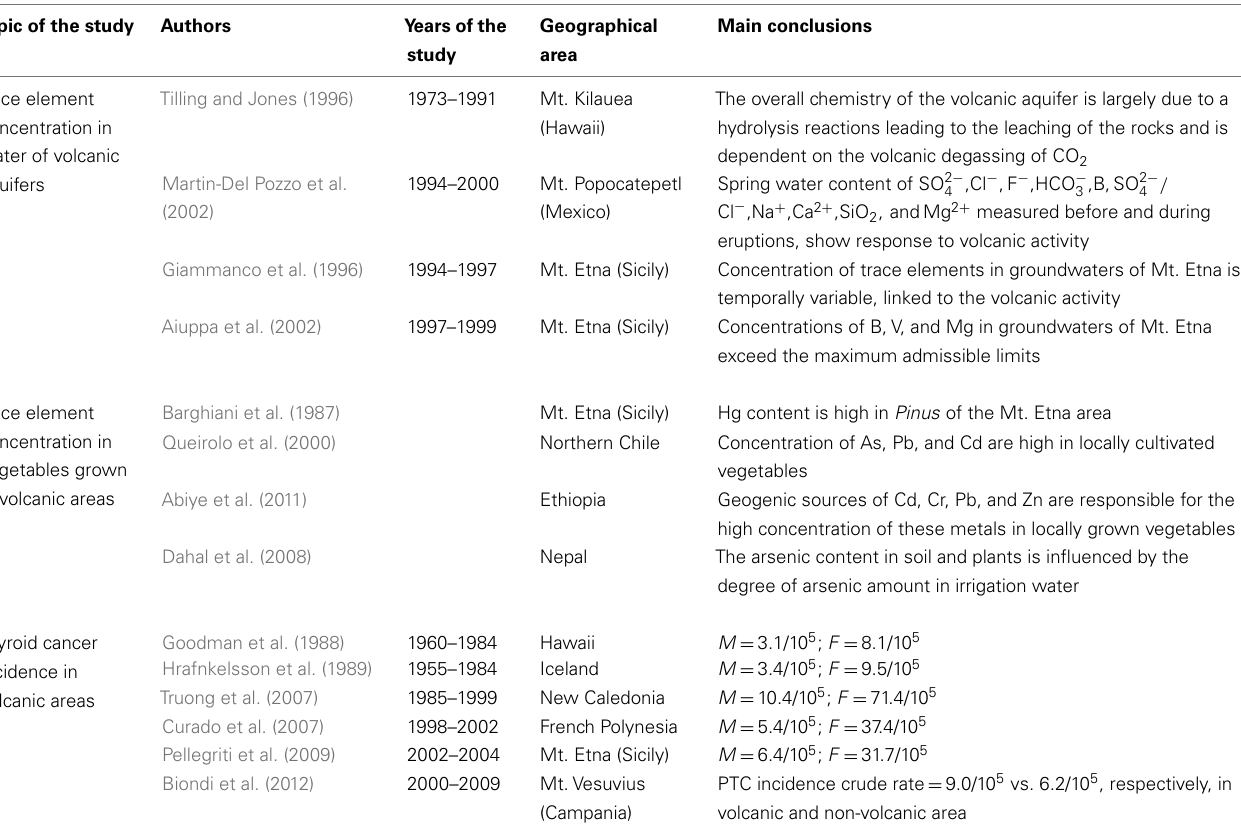
Table 4 | Summary of the principal studies quoted in the